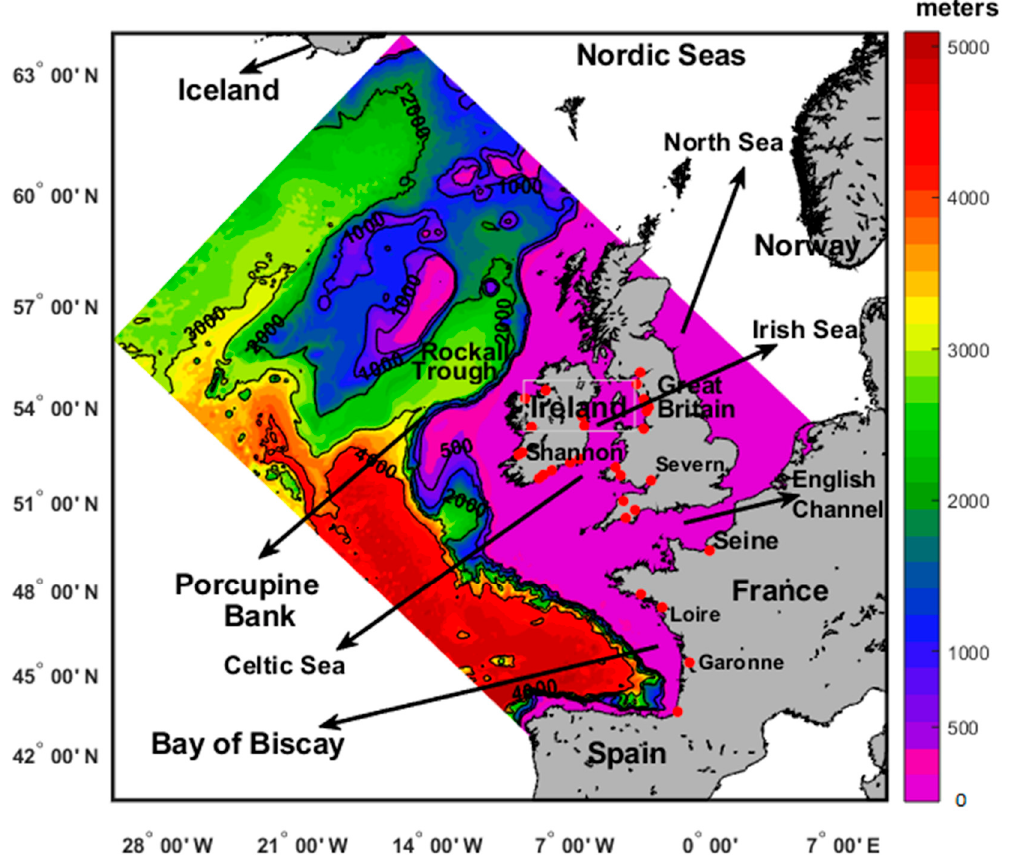
Figure 1. Bathymetric map of the area covered by the model. Major rivers included in the model are marked by red circles.